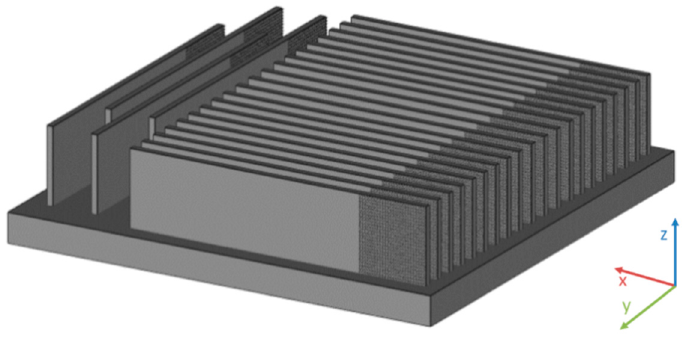
Figure 3. Position of tensile shear specimens on substrate plate .